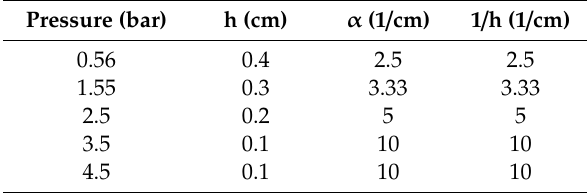
Table 1. h value measured for each pressure applied and the calculated α value for each value of h.